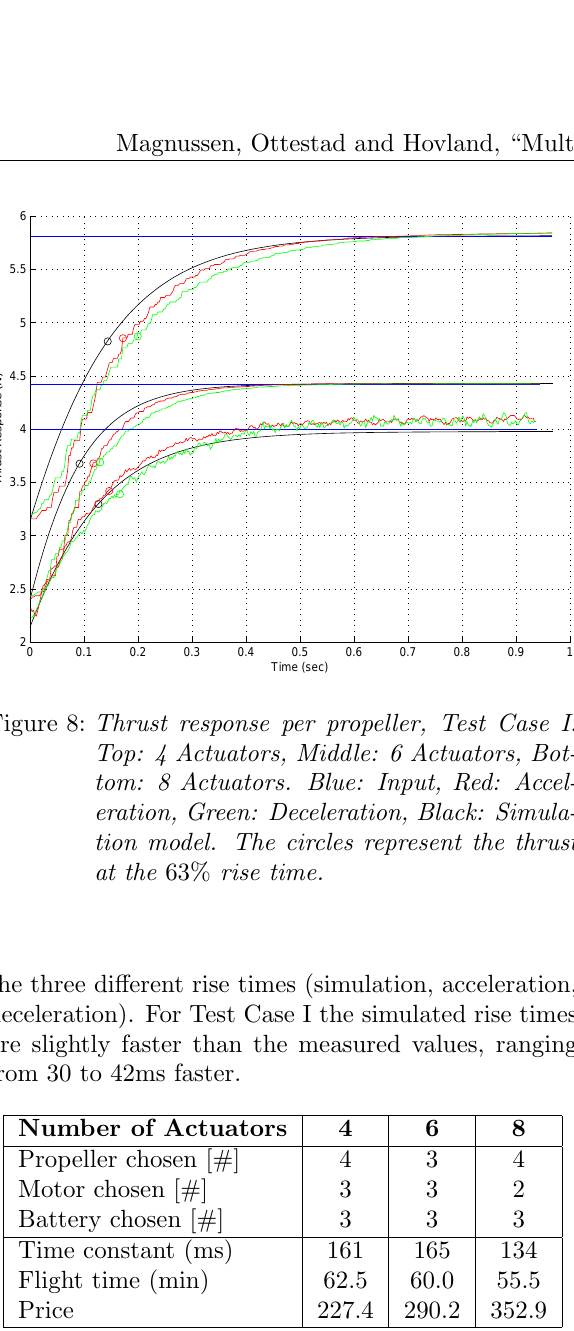
Table 8: Optimization Results: Test Case I.